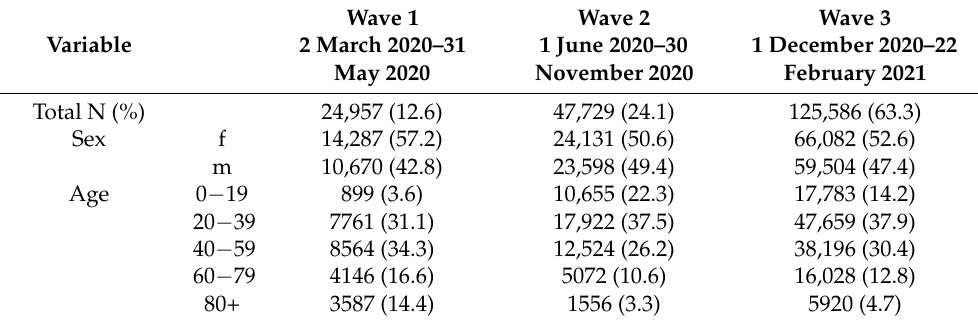
Figure 1. Distribution of all COVID-19 cases over time from the start of the pandemic in Ireland along with key lockdown dates. Three distinct waves are evident. Table 1. The number of cases in each wave of the pandemic in Ireland with a breakdown by age and sex.